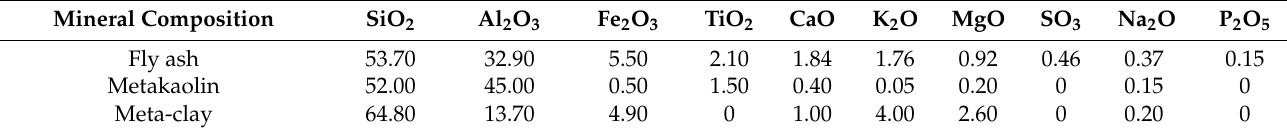
Table 1. Chemical composition of the geopolymeric cement [33,34].